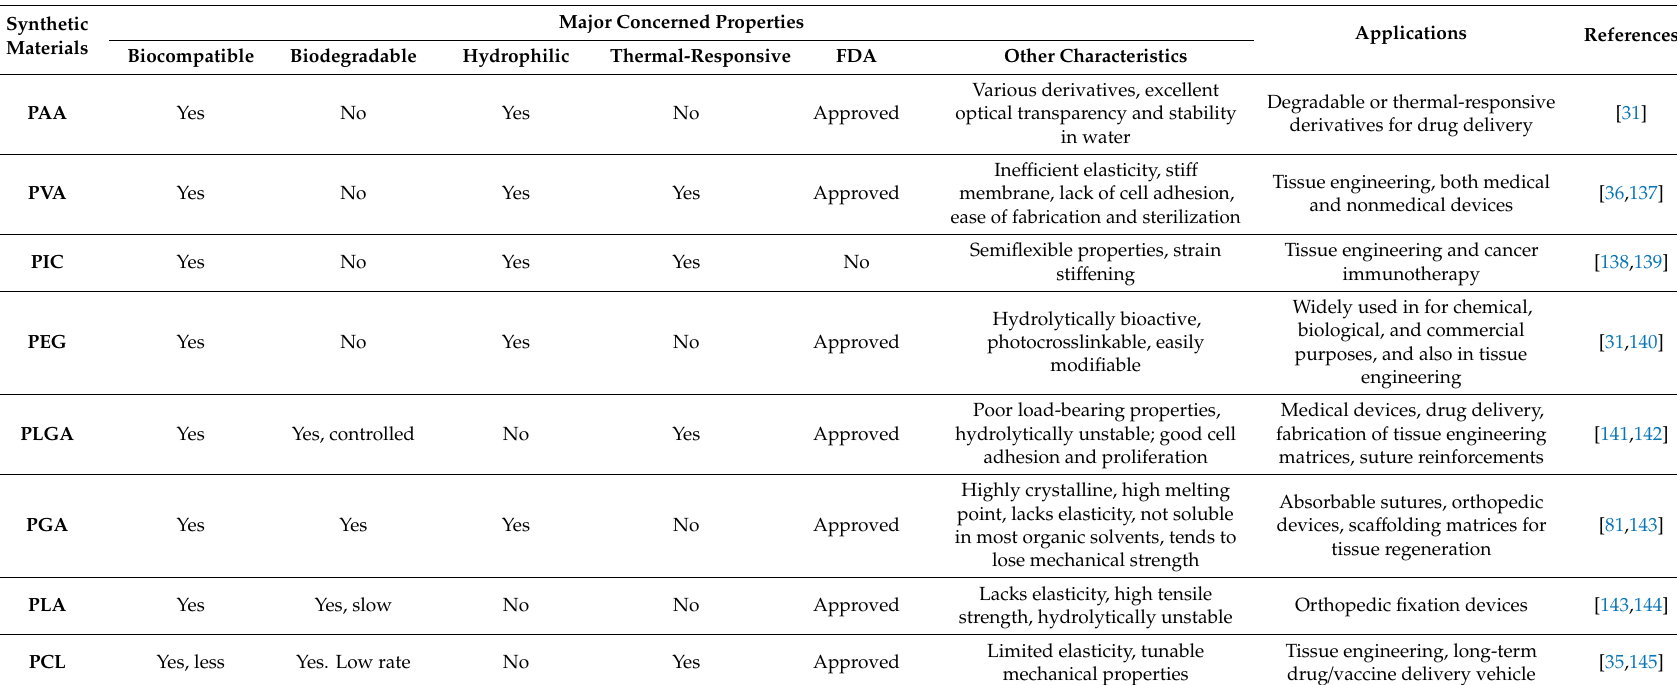
Table 2. Characteristics and applications of synthetic